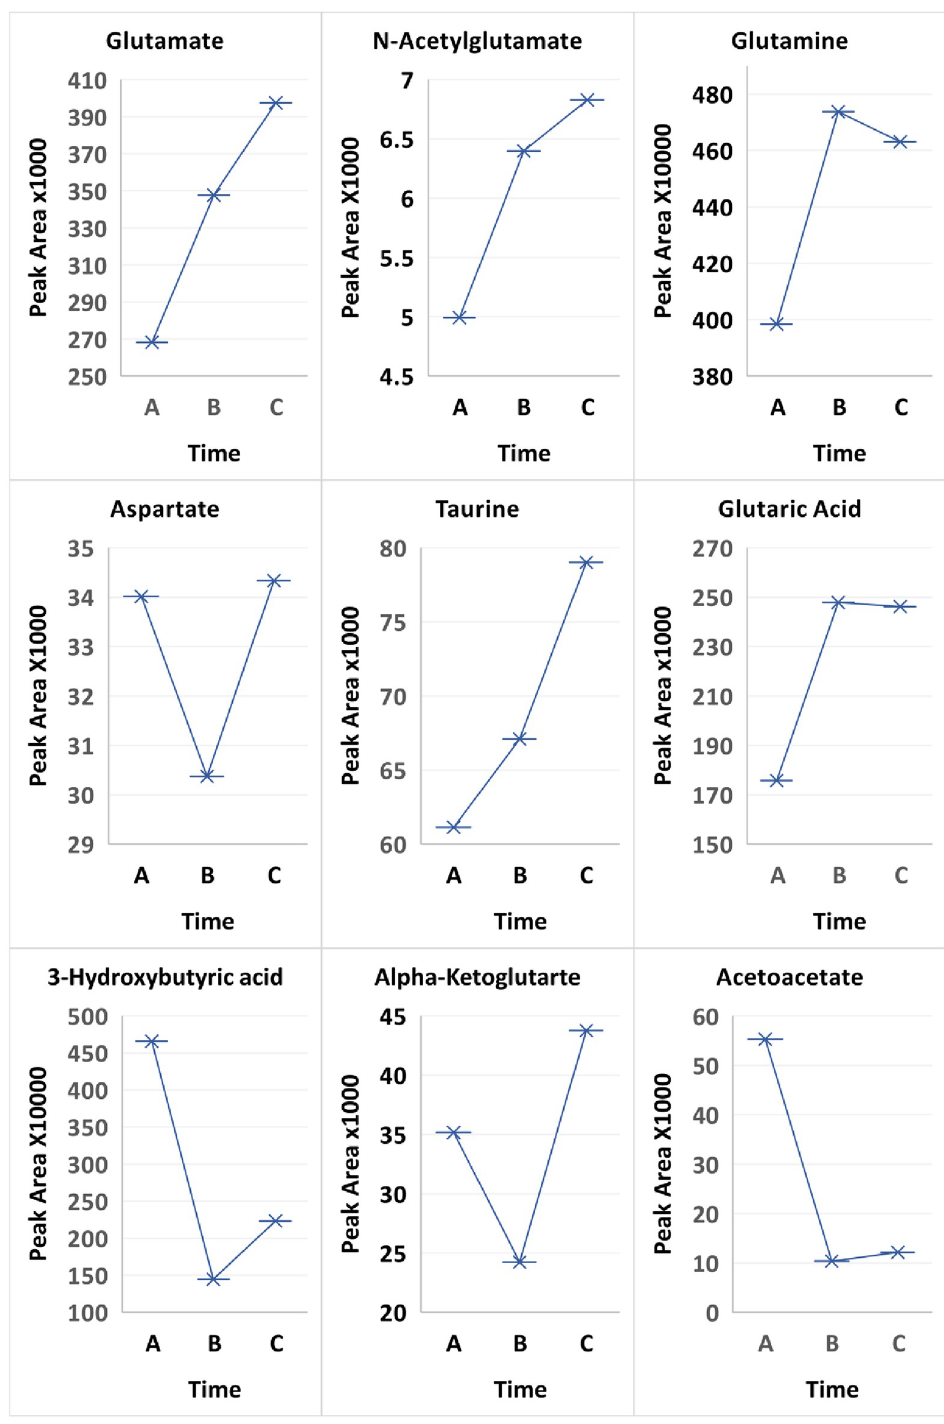
Fig 3. Comparison of treatment over 3 time points Time A at 6-12hours, Time B at 2 weeks and Time C at 3 months between all patients for metabolites glutamate, N-acetylglutamate, glutamine, aspartate, taurine, glutaric acid, acetoacetate and 3-hydroxybutyric